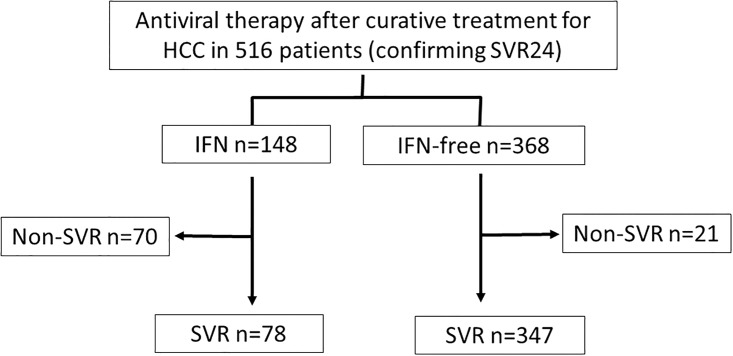
Flow sheet summarizing study selection.